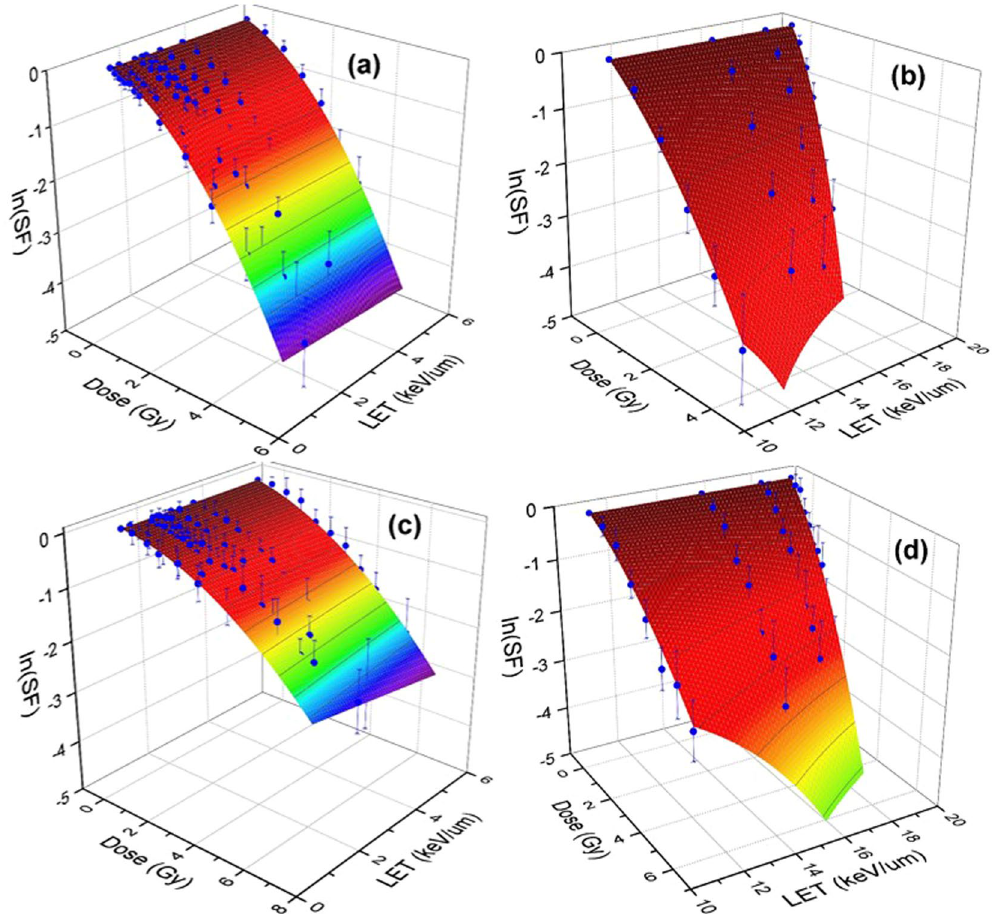
Figure 5. Shown H460 ( a , b ) and H1437 ( c , d ) cell survival surfaces in low ( a , c ) and high (b and d) LETs. As discussed in the text, LET ≈ 10 keV / μ m separates the low LET from high LET domain for 80 MeV pencil beam of proton. The gMKM polynomials have been used in a 3D global fitting approach to obtain the best-fitted surface to the experimental data. The numerical values of the fitting parameters are in linear ( a , c ) and non- linear ( b , d ) domains are presented in Table 1.